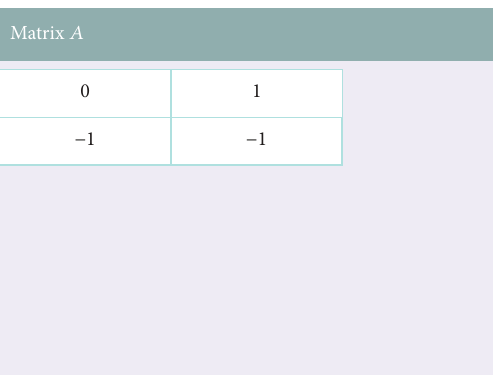
Figure 3: Matrix 𝐴 .